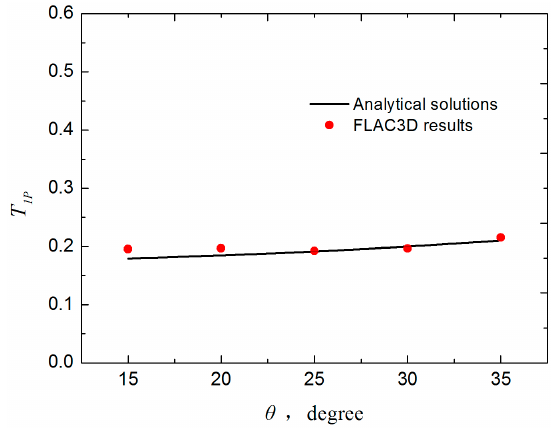
Figure 6. Relations between transmission coefficient T 1 P and incident wave angle θ for obliquely incident P wave transmission across a single joint.